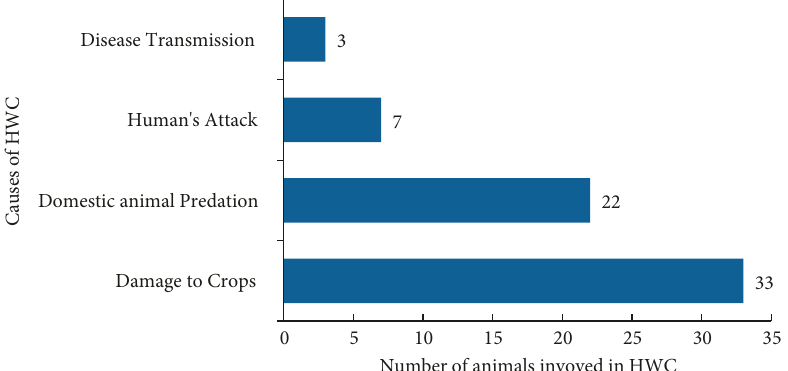
Figure 4: Terrestrial wildlife species involved in